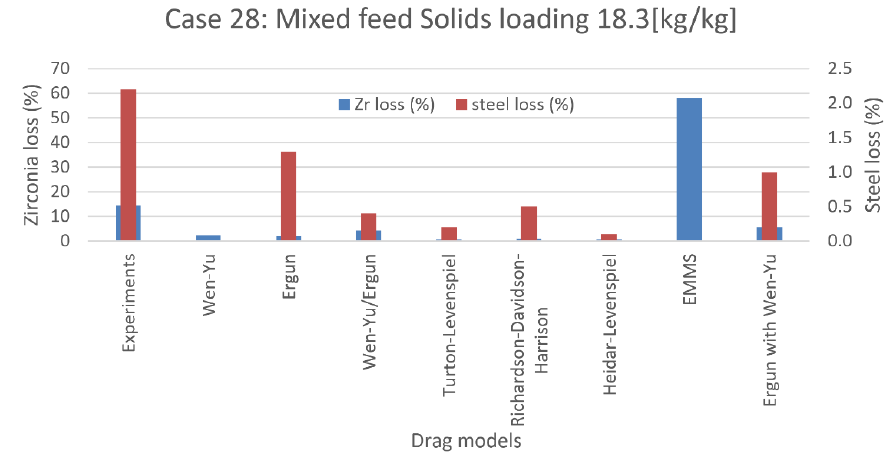
Figure 10. Zirconia and steel loss for Case 28.